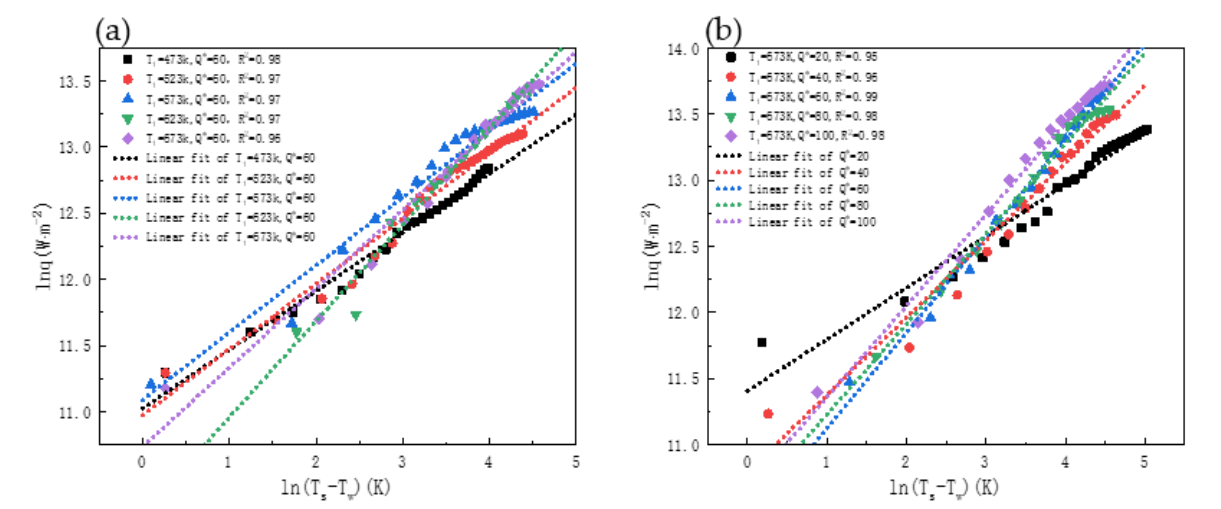
Figure 11. Correlation between data calculated based on Equation (19) and the data gained by DC secondary cooling simulator: ( a ) different T i at 473, 523, 573, 623, 673 K, respectively, at 60 L min − 1 m − 1 ; ( b ) different Q ∗ at 20, 40, 60, 80, 100 L min − 1 m − 1 at 673 K.